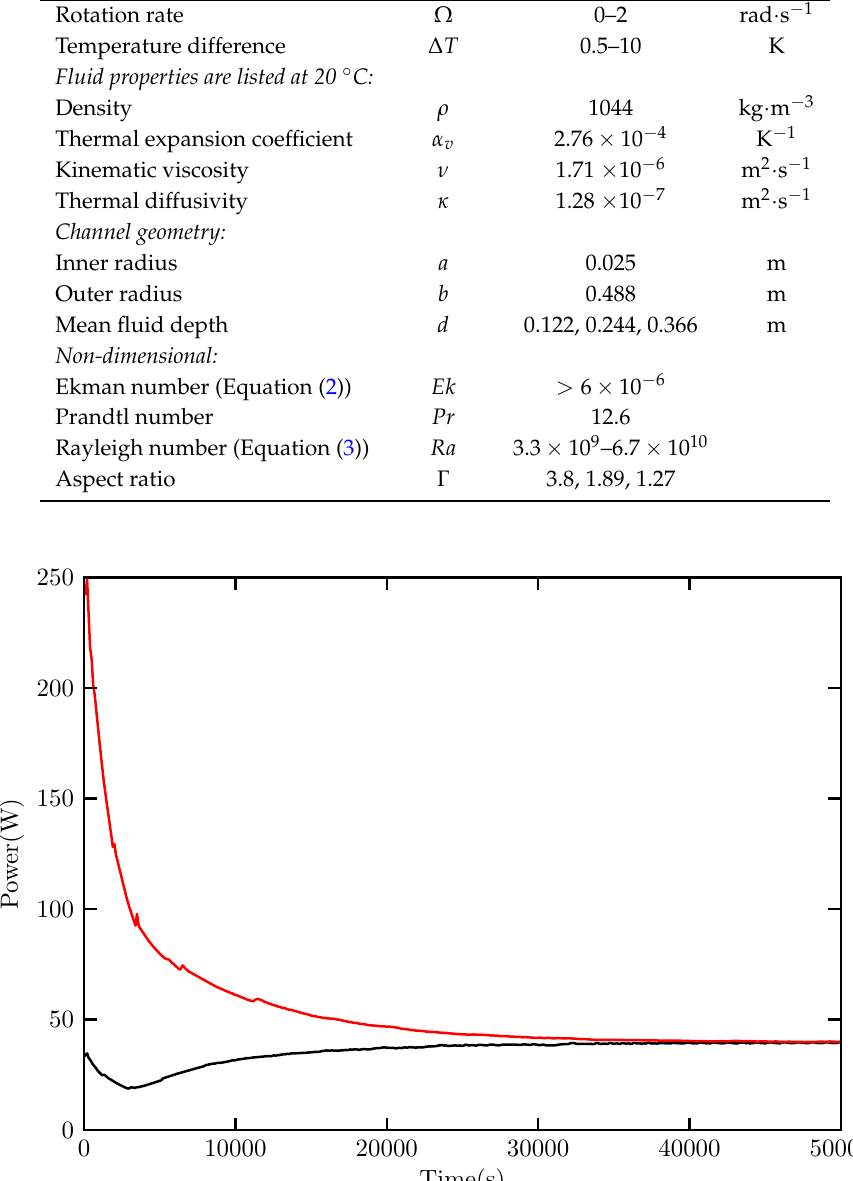
Figure 2. The time series of total power (W) for ∆ T = 10 °C, Ω = 1 rad line shows the power dissipated by the heat sink and the black line the power input by the heat source, these converge after a stabilisation time of about 45,000